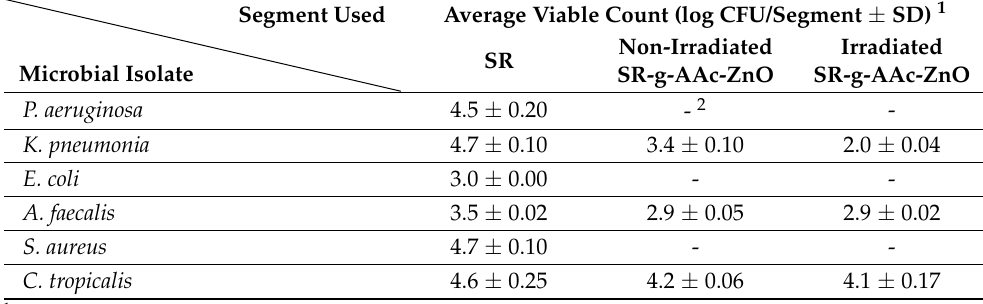
Table 5. Mean log viable count of adhered cells on 5 × 5 mm silicone segments after 72 h incubation. Microbial Isolate